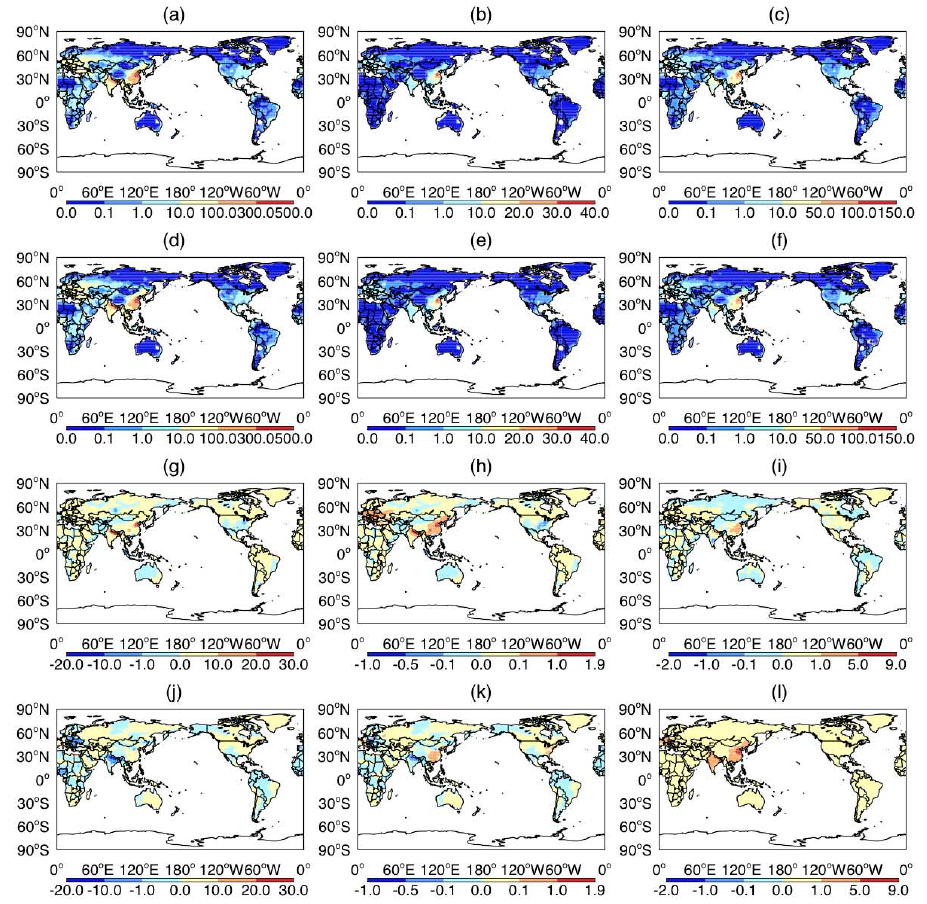
Fig. 5. Annual cardiopulmonary (a, d, g, j) , lung cancer (b, e, h, k) and respiratory mortalities (c, f, i, l) (unit: deaths/1000km 2 ) attributed to total changes in PM 2 . 5 and O 3 from preindustrial to present (“2000” minus “1860” simulations) (row 1, a, b and c ); changes in PM 2 . 5 and O 3 over that time interval due to increases in short-lived anthropogenic air pollutant emissions only (“2000” minus “2000CL1860EM” simulations) (row 2, d, e and f ); due to climate change only (“2000” minus “1860CL2000EM” simulations) (row 3, g, h and i ); and due to the impact of CH 4 increases on tropospheric chemistry only (“1860CL2000EM” minus “1860ALL2000EM” simulations) (row 4, j, k and l